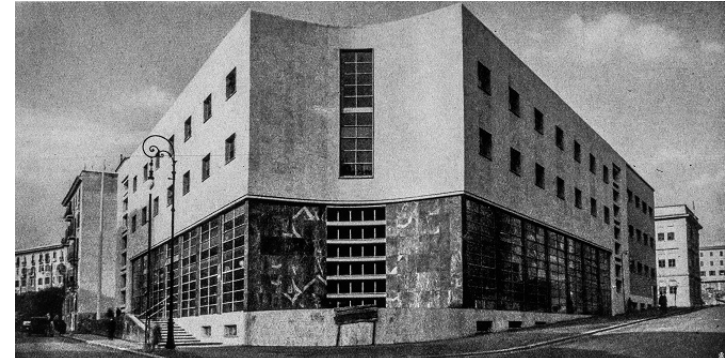
Figure 12. Post Office building by Mario Ridolfi. Rome (1933–1935). Photo from (Poretti 1990, p. 88. Source: Museo storico delle poste e telecomunicazioni).